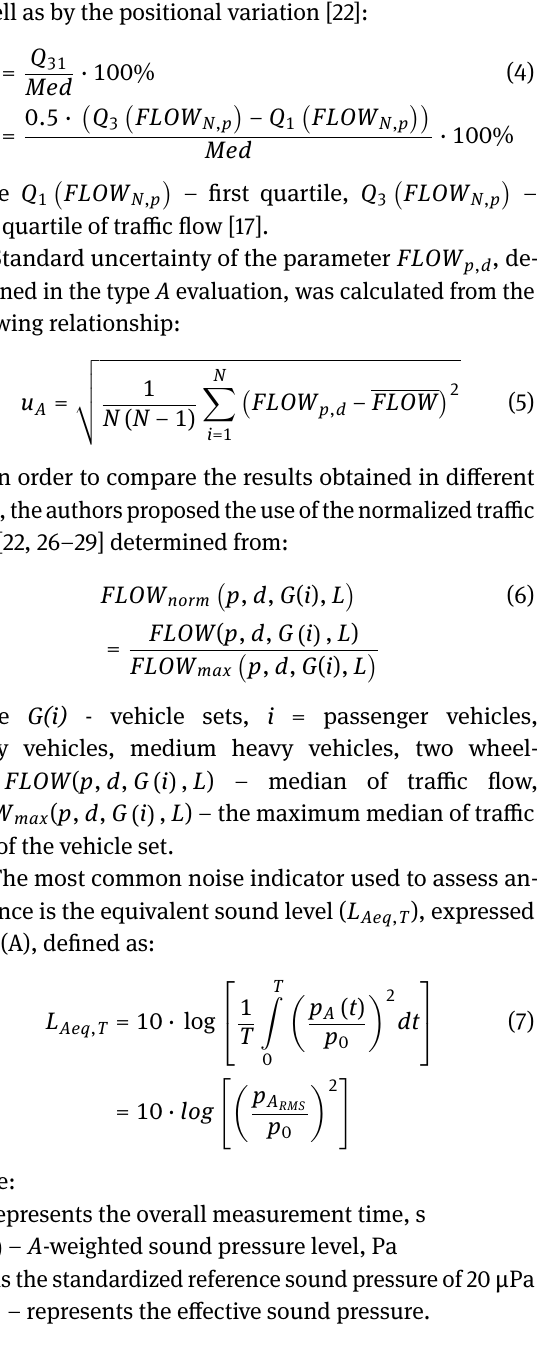
Table 1: Median of the annual daily traflc flow in